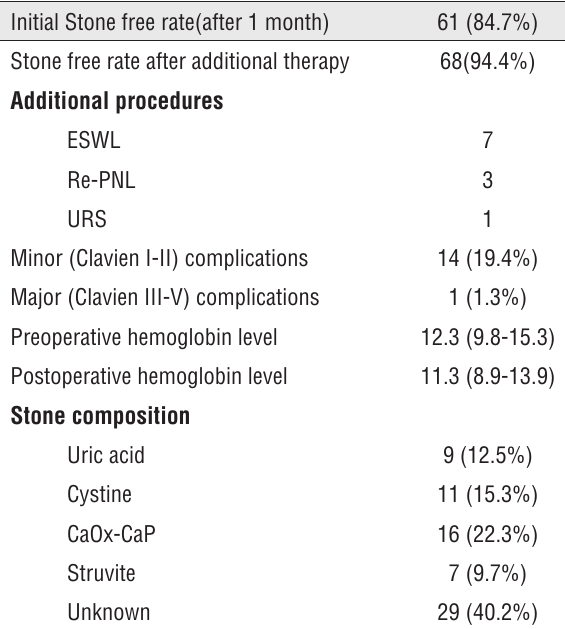
Table 3 - Postoperative